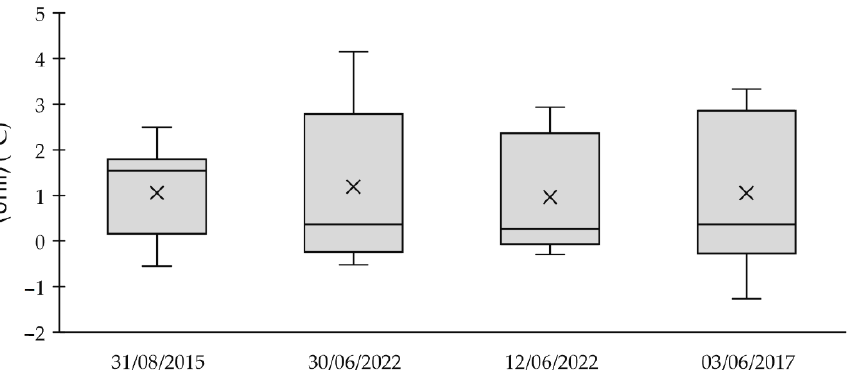
Figure 8. Boxplot comparison of the daily corrected ⟨ UHII ⟩ amplitude, range, and distribution for all four scenarios calculated from the 10-min timestep.